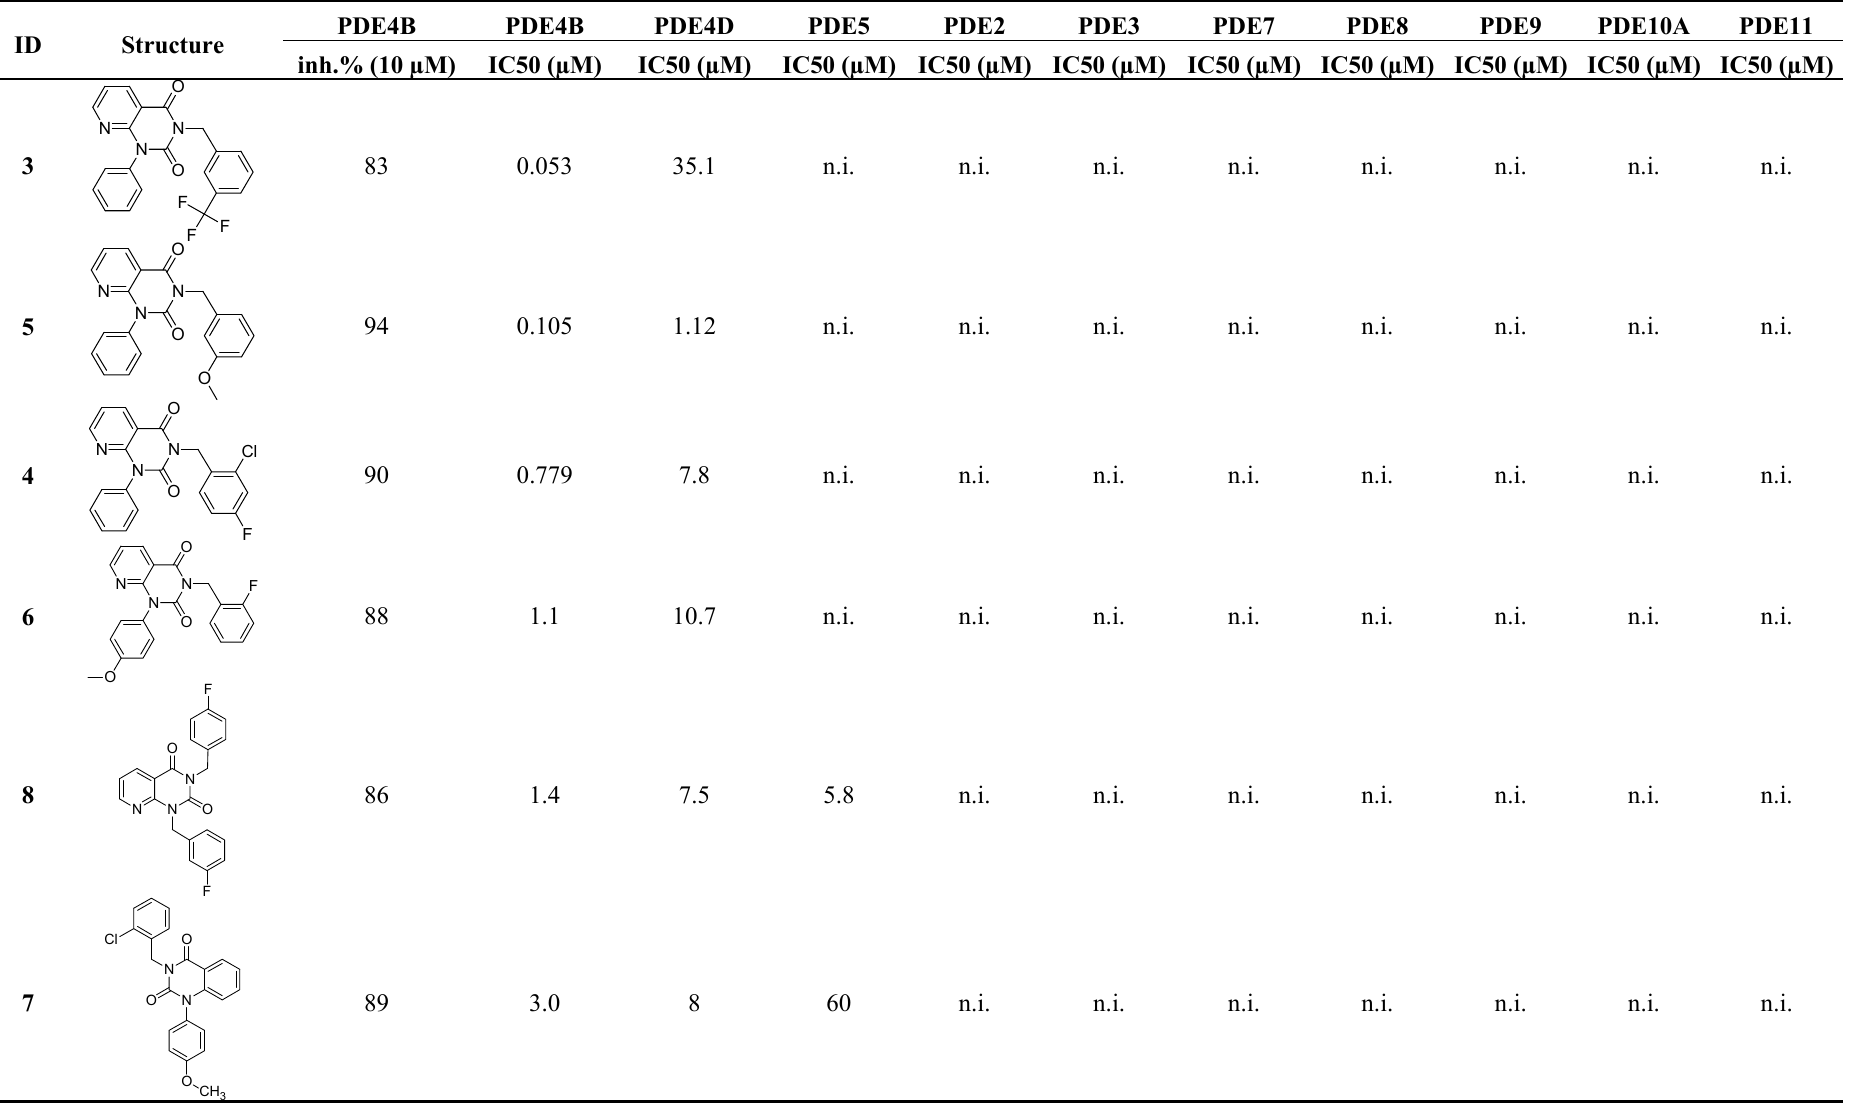
Table 5. The activity profile of 11 selected hit compounds (n.i. denotes no